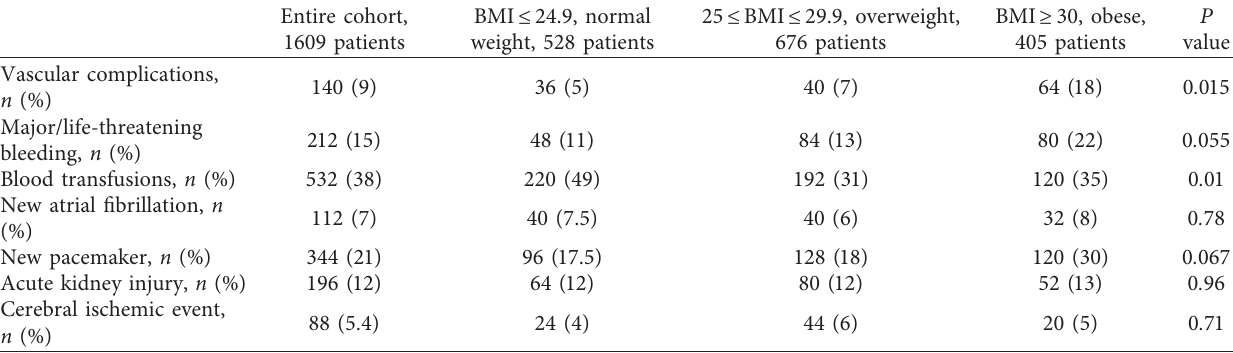
Table 3: Clinical outcomes according to BMI